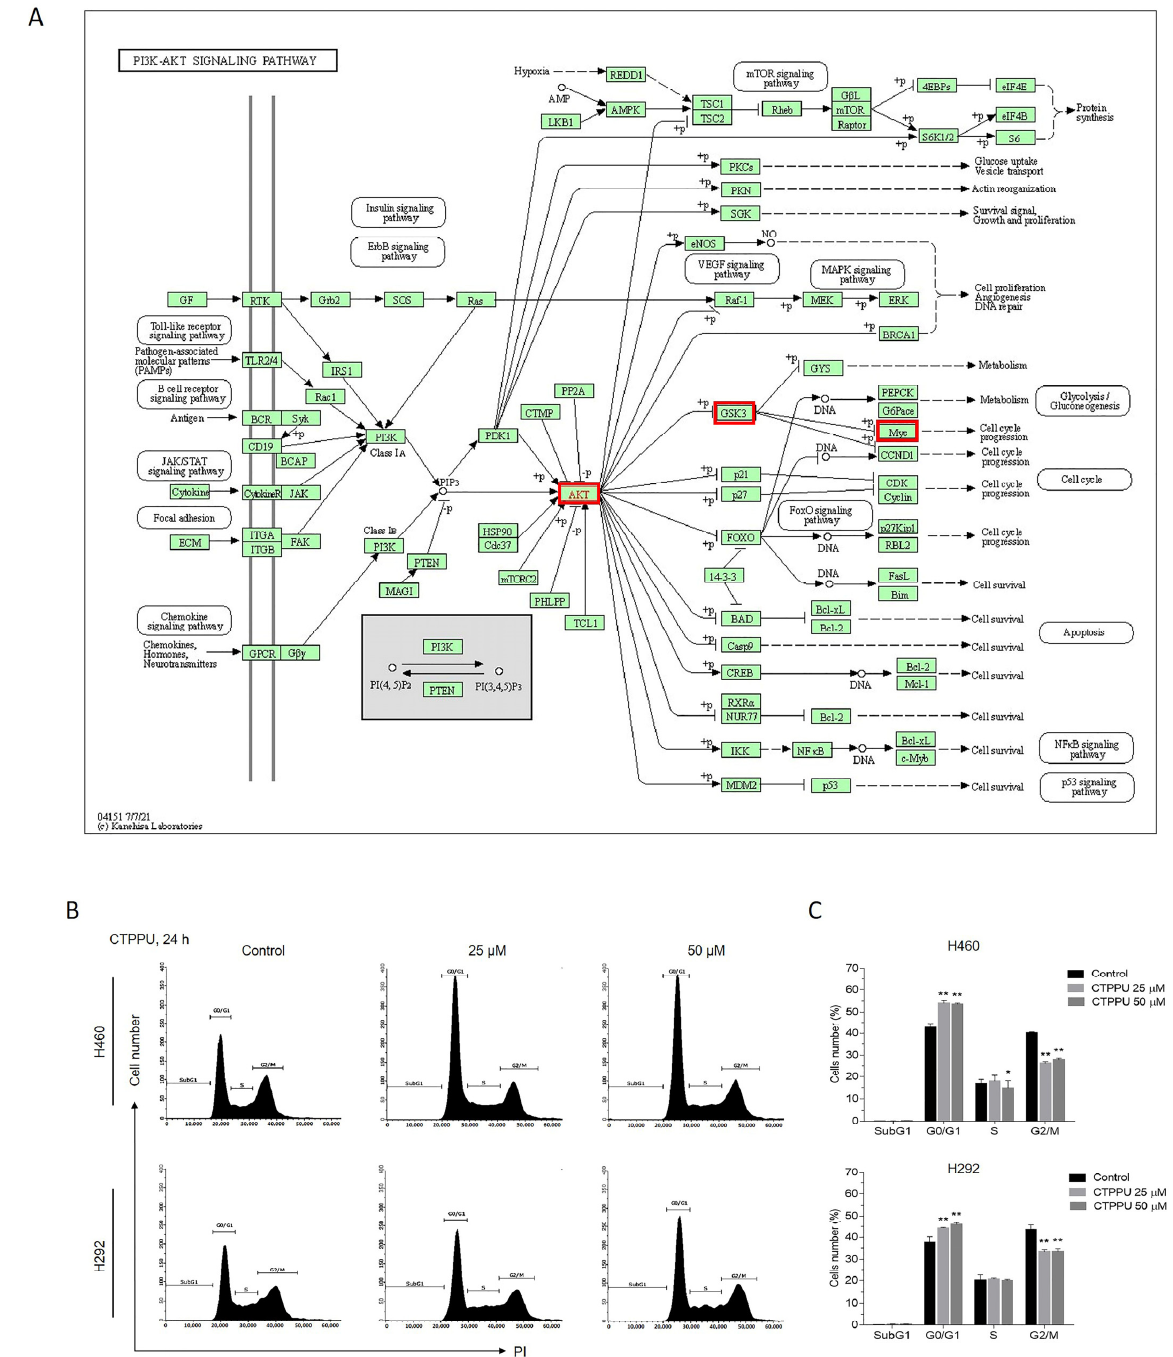
Figure 6. Effect of CTPPU on cell cycle progression of NSCLC cells. ( A ) The KEGG mapper database revealed potential Akt downstream signals involved in cell cycle progression. The red box represents the proteins affected by CTPPU treatment. ( B ) After serum starvation of 48 h, cells were treated with 25 or 50 µM of CTPPU, as indicated, for 24 h. The cell cycle distribution was analyzed through flow cytometry with PI staining. ( C ) The percentage of cells number in each phase of the cell cycle (sub G1, G0/G1, S, and G2/M) is indicated. Each value is the mean ( ± SD) from triplicate samples. * p <0.05 and ** p < 0.01 compared with the